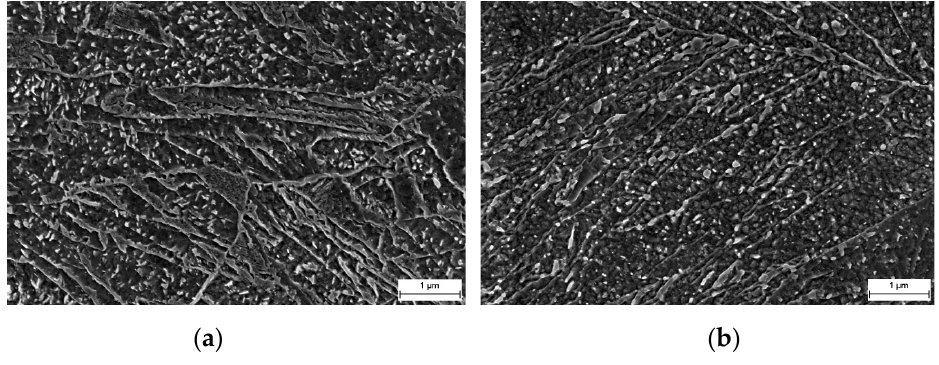
Figure 2. SEM images. ( a ) As ‐ quenched. ( b ) After aging for 4 h at 600 °C.